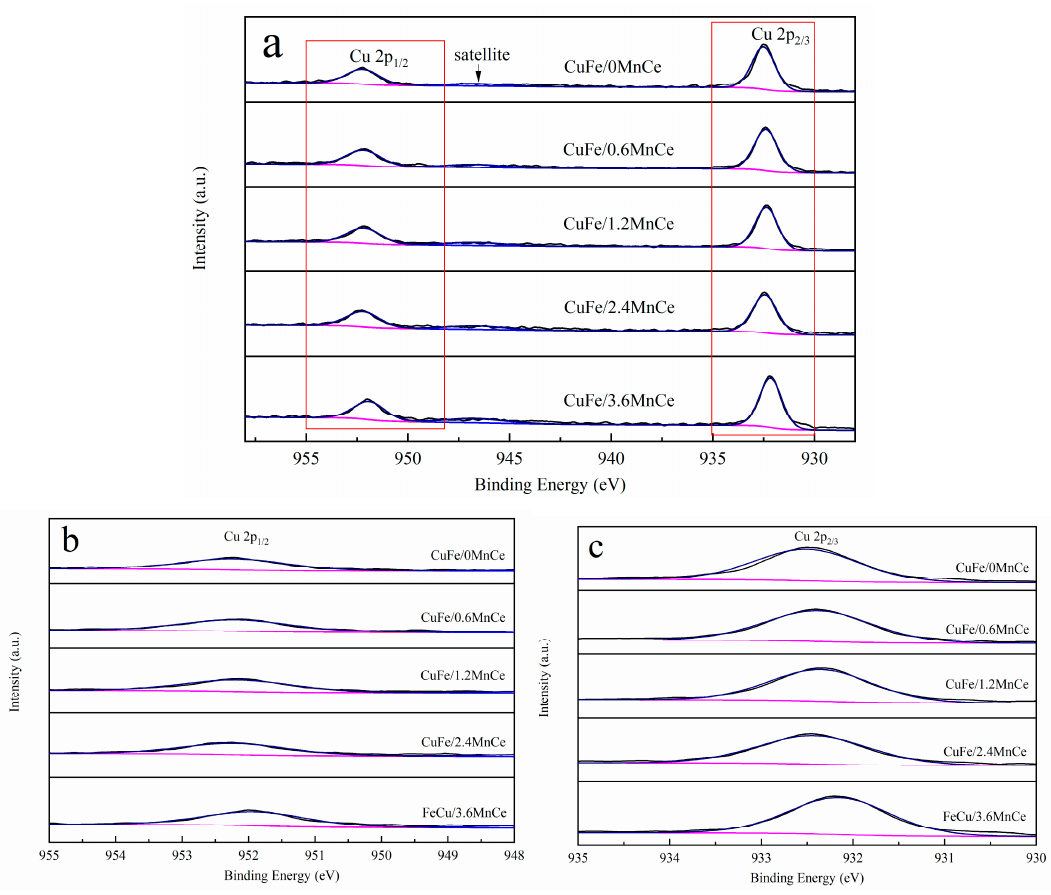
Figure 4. Cu 2p XPS spectra of catalysts after reaction: ( a ) Cu 2p, ( b ) Cu 2p 1/2 , ( c ) Cu 2p 3/2.